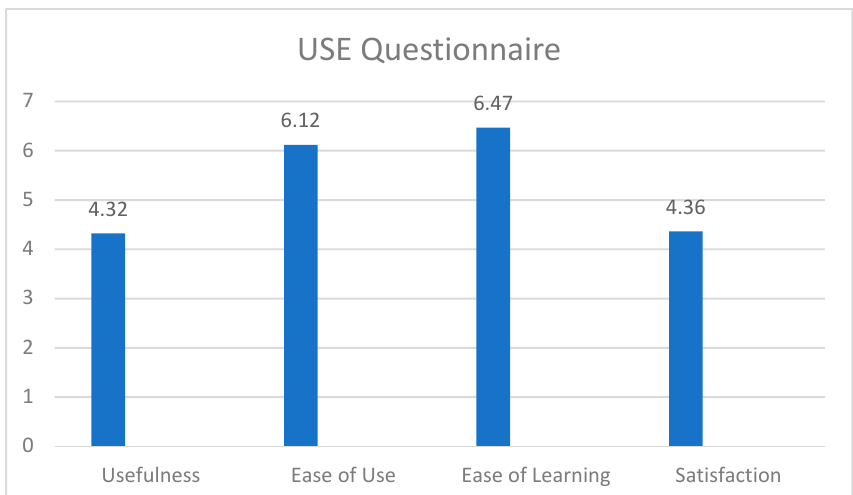
Figure 6. USE questionnaire mean values.